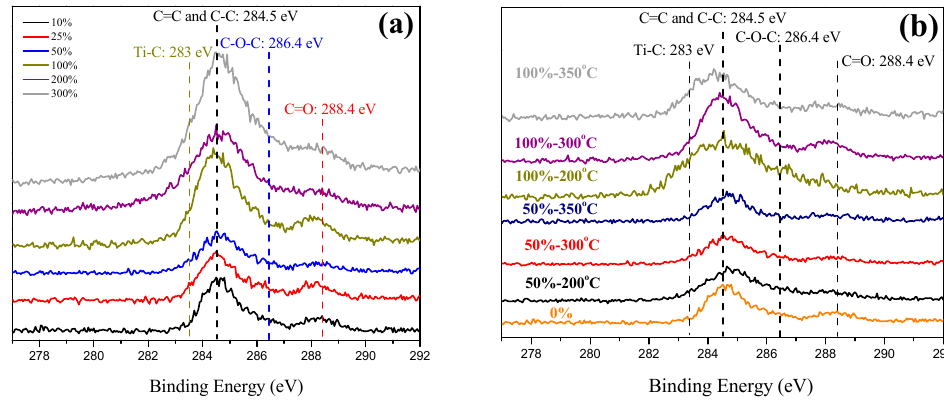
Figure 10. ( a ) C 1S XPS spectra of various C–TiO 2 films synthesized in different glucose aqueous